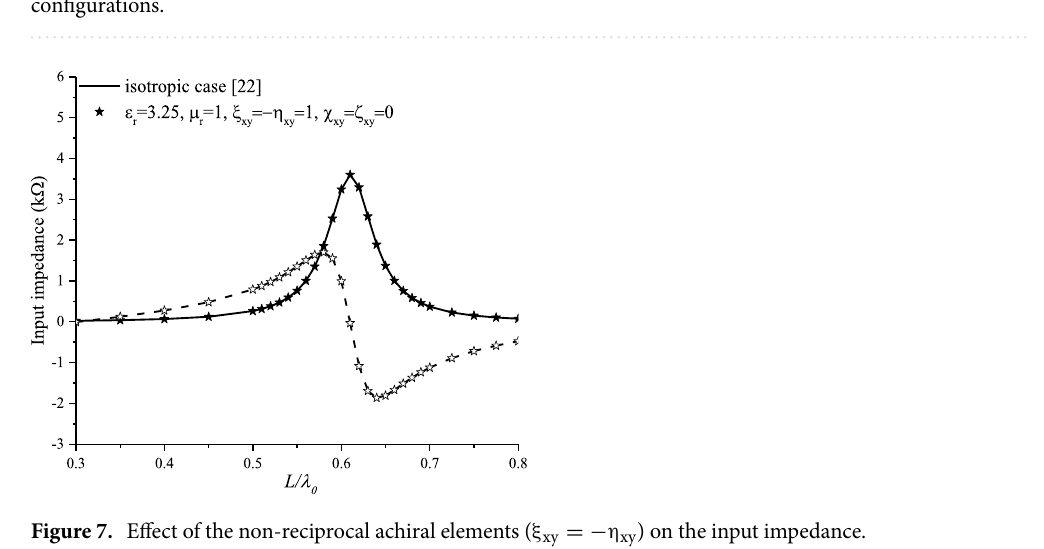
Fig. 11, from the zero crossing of the reactance curve (imaginary part) 37,38 . Figure 12 shows that the resonance frequency decreases significantly with increasing reciprocal Tellegen medium, unlike the case where the ele- ments are purely imaginary.